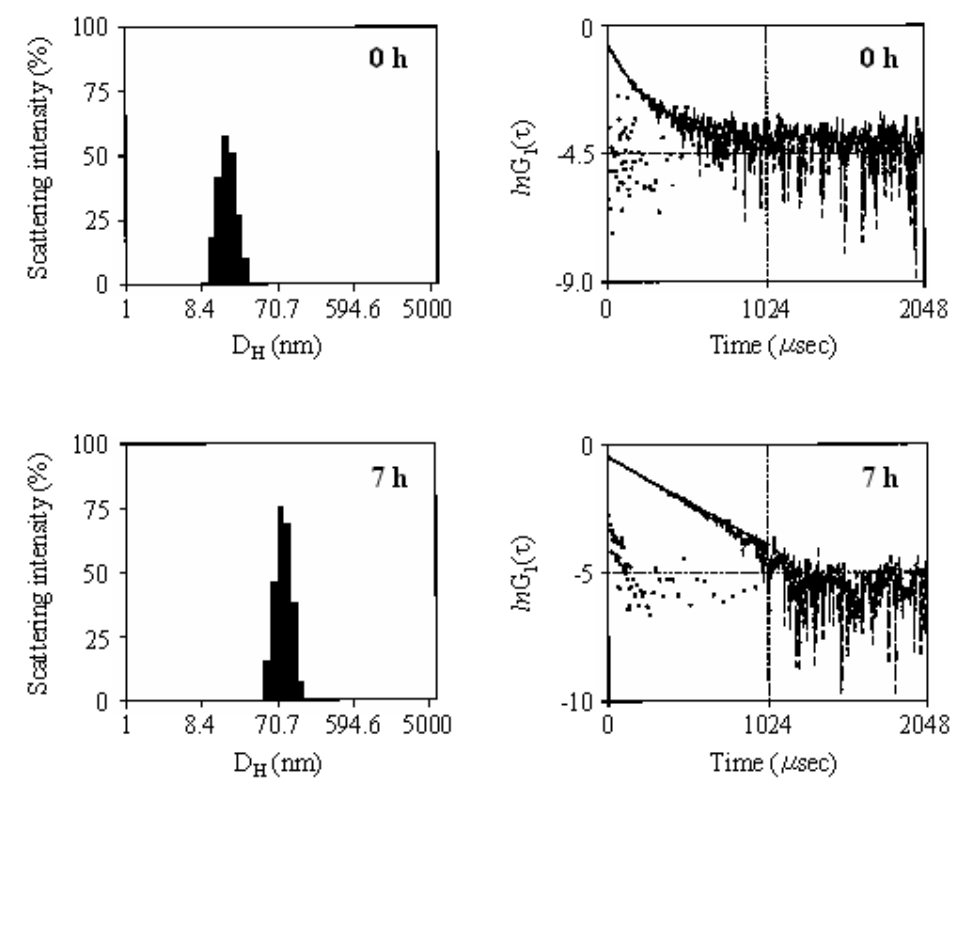
Figure 9. The scattering intensity distributions of the hydrodynamic diameter (D plots of ln G (τ) vs.  for PPySt- b -PSt before (upper) and after the irradiation for 7 h 1 (lower). [PPySt- b -PSt] = 2.86